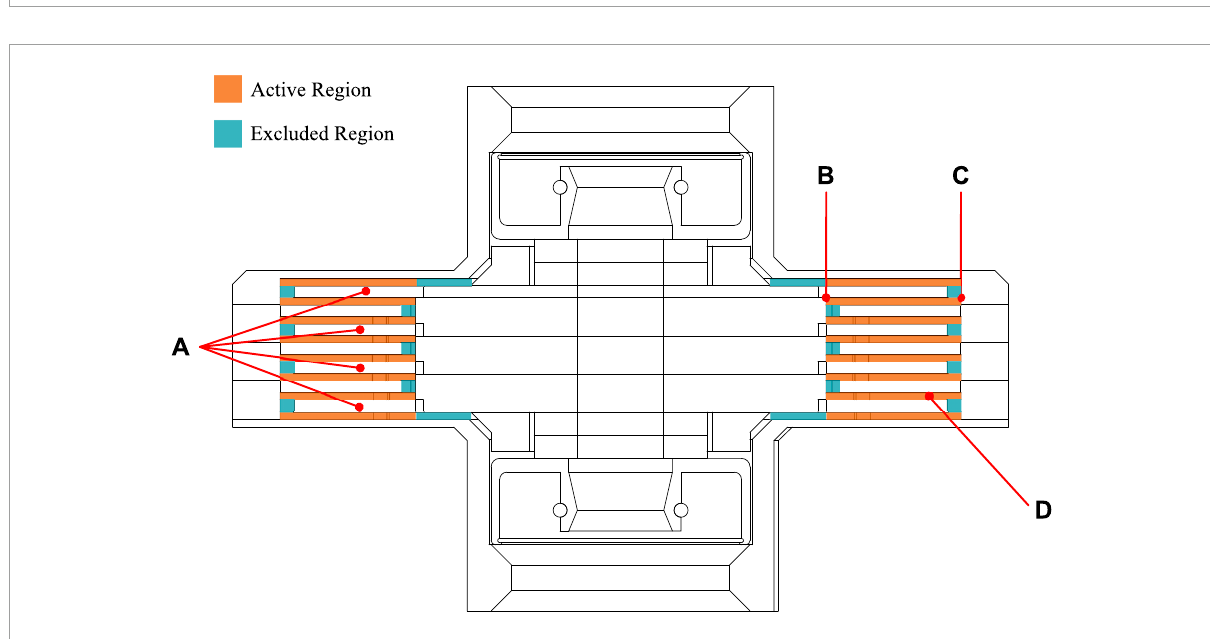
FIGURE 4 The cross-section of the active region of the MRF clutch design. The horizontal regions highlighted in orange are described with the total torque from Eq. 8 , while the regions in blue are excluded from the model. The MRF fills the empty space (both blue and orange) inside the MEC, between each of the interdigitated fins inside all available internal space not taken up by the fins or the inner and outer walls of the device. (A) The number of fins (here, there are four), (B) The inner radius (C) The outer radius, and (D) the gap